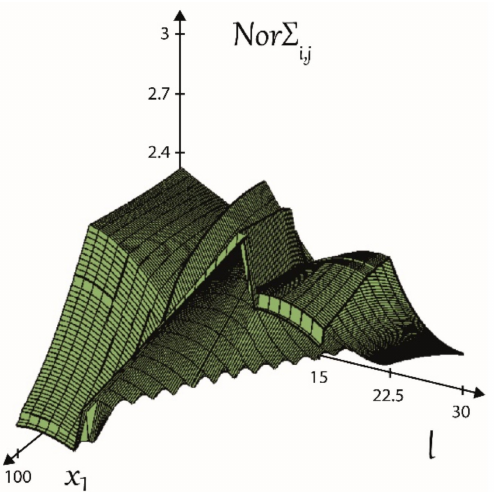
Figure 7. The surface of the function of the cumulative effectiveness as a bivariate function. The function is formed by the Almen product, the Hertzian stress, and the lubricating film thickness as target functions.